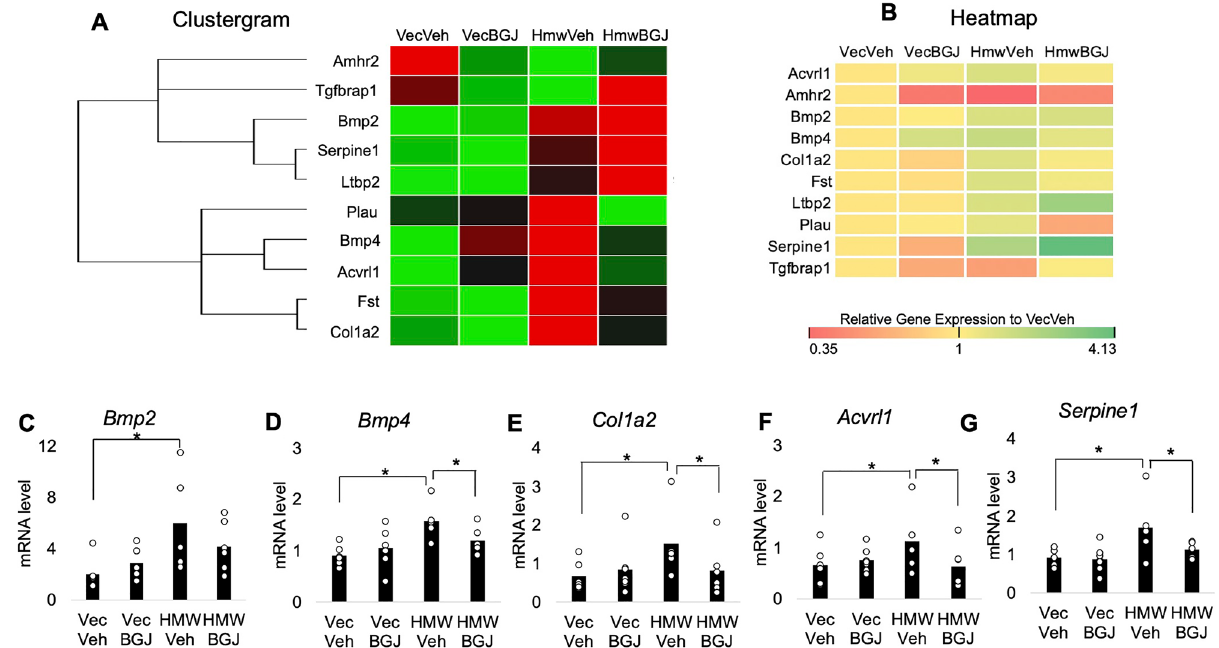
Figure 7. Gene expression of TGFβ/BMP signaling pathway in knee joint of 8-month-old Vector-Control and HMWTgFGF2 mice treated with BGJ398. Six and a half-month-old Vector-Control (Vec) and HMWTgFGF2 (HMW) male mice were sq injected with vehicle or BGJ398 5 days/week for 6 weeks. At the end of the experiment (8 months old) knee joints were collected and total RNA was isolated and reverse transcribed. The mRNA levels of 82 genes involved in the Tgfβ/BMP signaling pathway were detected using a pre-designed PrimePCR assay kit following the manufacturer’s instructions. The results were analyzed using Bio-Rad CFX manager software. The clustergram and heatmap of the 82 genes in Tgfβ/BMP signaling pathway in Vector- Control (Vec) and HMWTgFGF (HMW) mice treated with vehicle or BGJ398 are shown in Supplemental Figs. 5 and 6. ( A ) The clustergram of the 10 target genes that were increased or decreased 1.4 fold. ( B ) Representative heatmap of the 10 differentiated genes expressed in knee samples from Vector-Control or HMWTgFGF2 mice treated with vehicle or BGJ398. HMWTgFGF2 knees display altered genes in the TGIFβt/ BMP signaling pathway and rescued by BGJ398. ( C – G ) represent qPCR confirmation of the genes that are significantly altered in the PrimePCR array. Data are shown as mean and individual points. n = 5–7 mice/group. *p < 0.05 by two-way